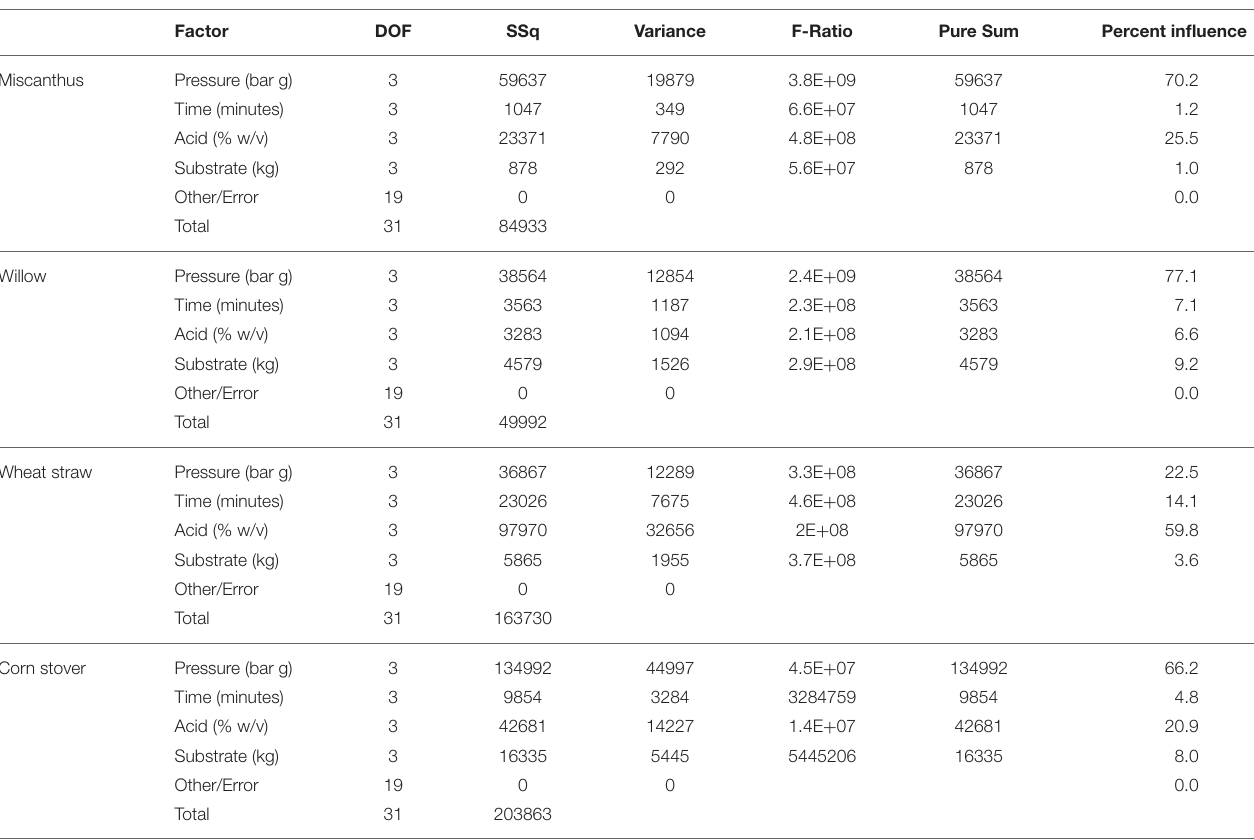
TABLE 4 | Analysis of variance of factor levels on xylose release of feedstock n = 2. Factor DOF SSq Variance F-Ratio Pure Sum Percent